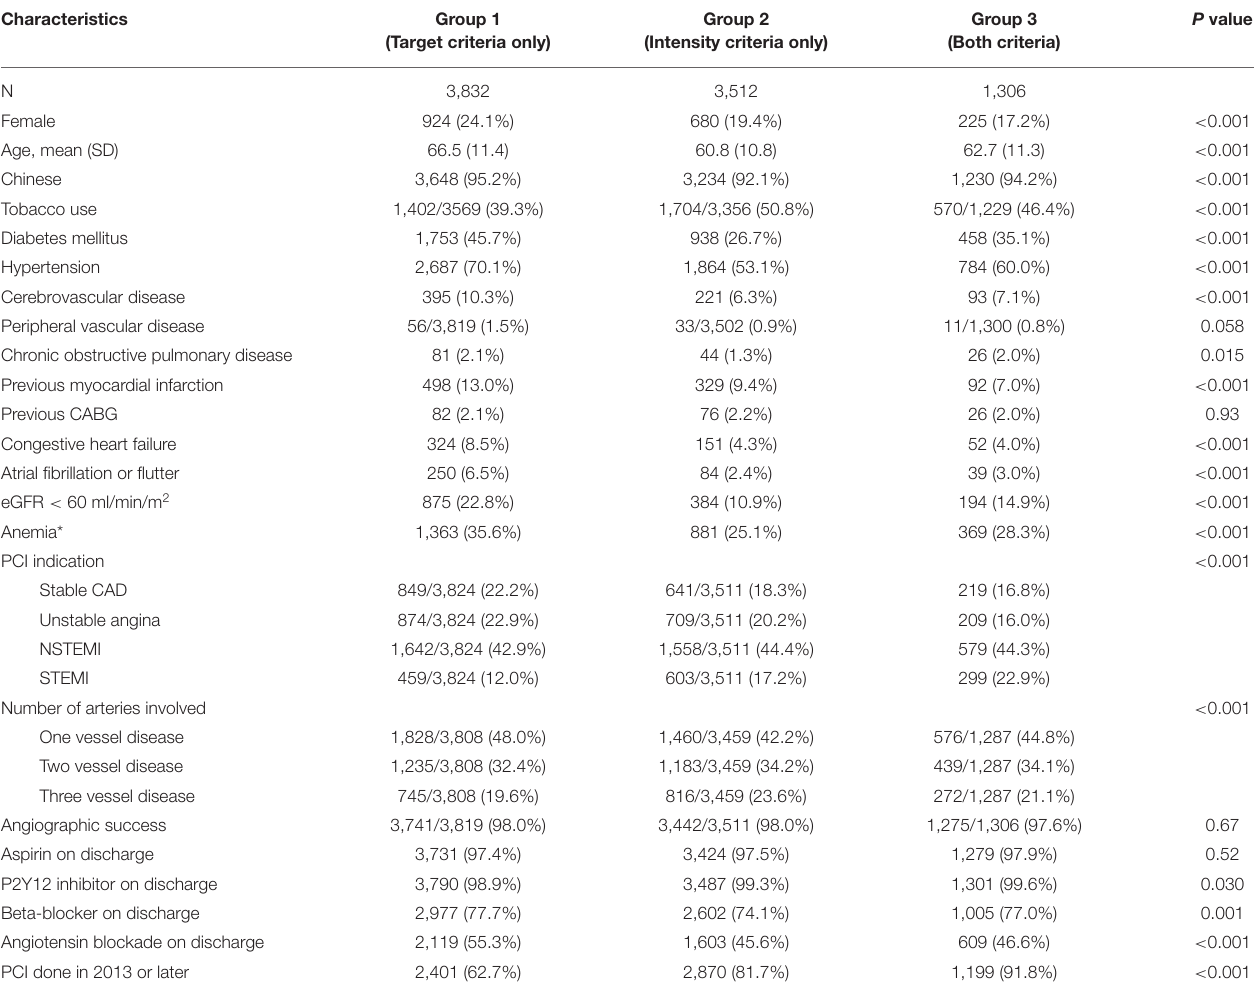
TABLE 1 | Baseline characteristics of patients.